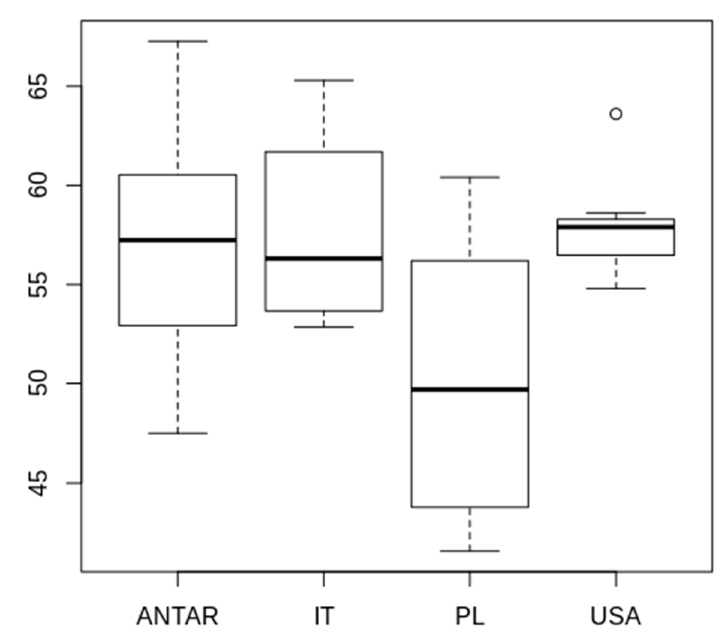
Figure 6. Differences in the buccal tube length (in micrometres ( μ m)) between the studied populations of Paramacrobiotus fairbanksi Schill, Förster, Dandekar and Wolf [25] (Antar, Antarctic; IT, Italy; PL, Poland; USA, USA). Minimum, maximum, median, first quartile, and third quartile for each population are presented.